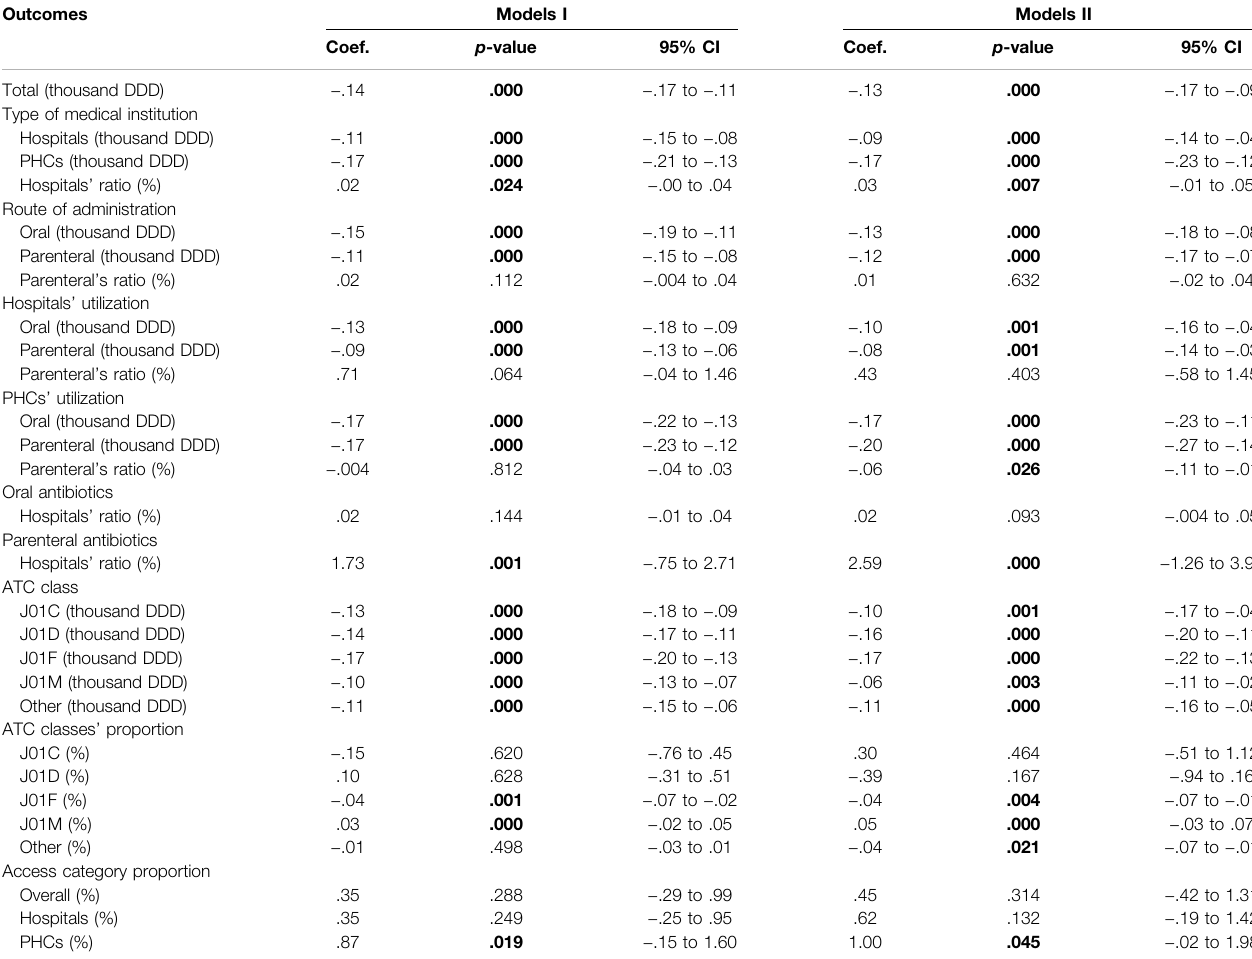
TABLE 4 | Generalized linear regression models on the change of antibiotic utilization under the COVID-19